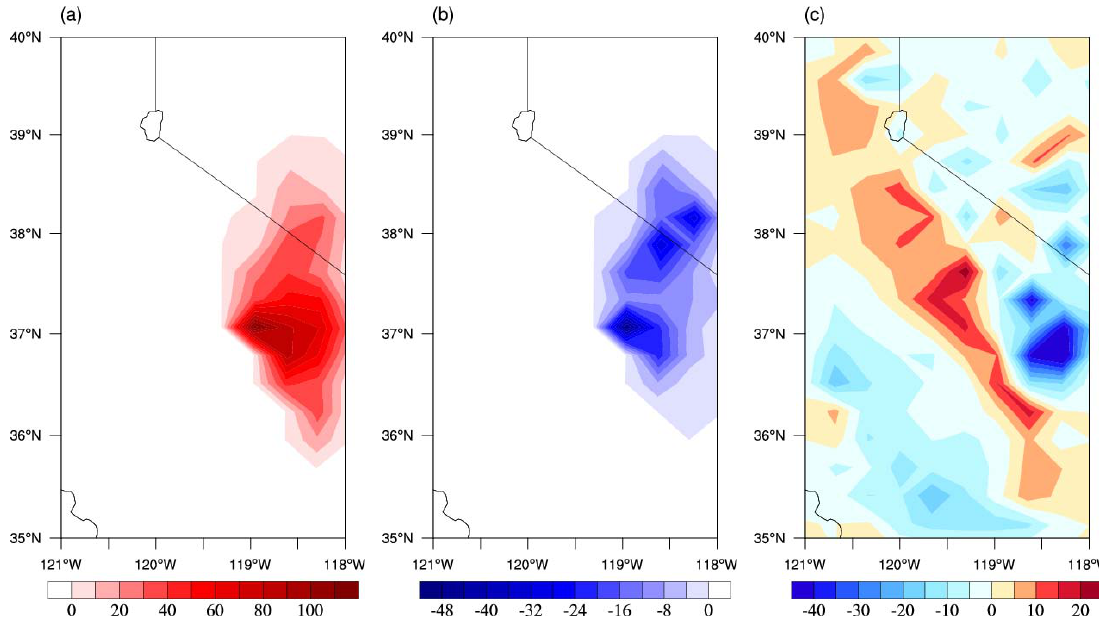
Fig. 5. (a) Cloud water path (CWP, gm − 2 ) simulated in the CTRL experiment, (b) differences in CWP due to the mountain effect, and (c) differences in surface solar insolation (Wm − 2 ) due to the mountain effect at 1p.m. on 29 March